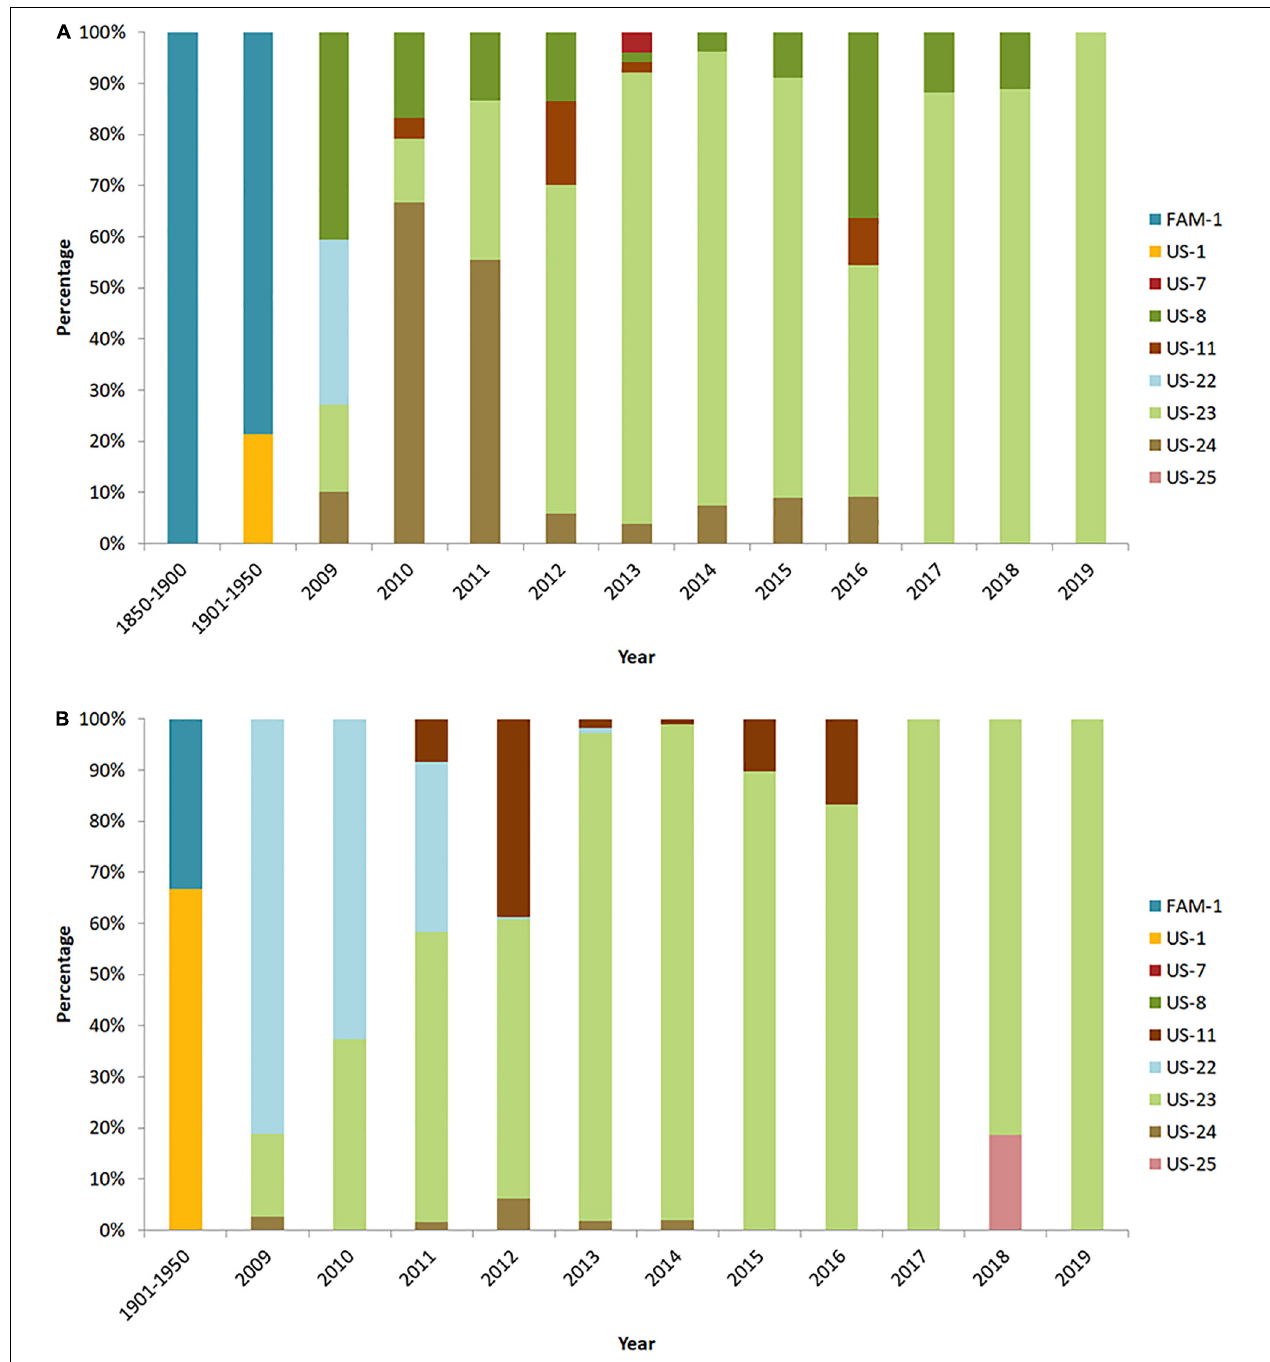
FIGURE 4 | Distribution of United States lineages of P. infestans from herbaria (1850–1950) and modern United States collections (2009–2019) on (A) potato and (B) tomato. Data from 2011 to 2019 are from